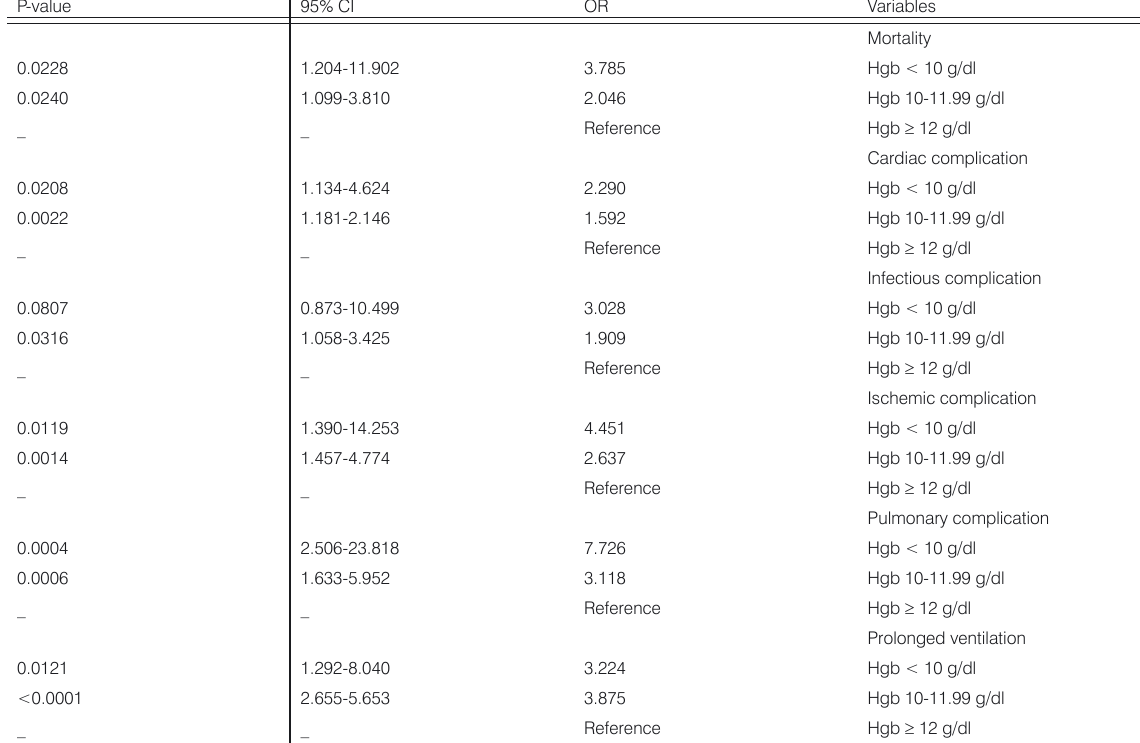
Hgb, Hgb; CI, confidence interval; OR, odds